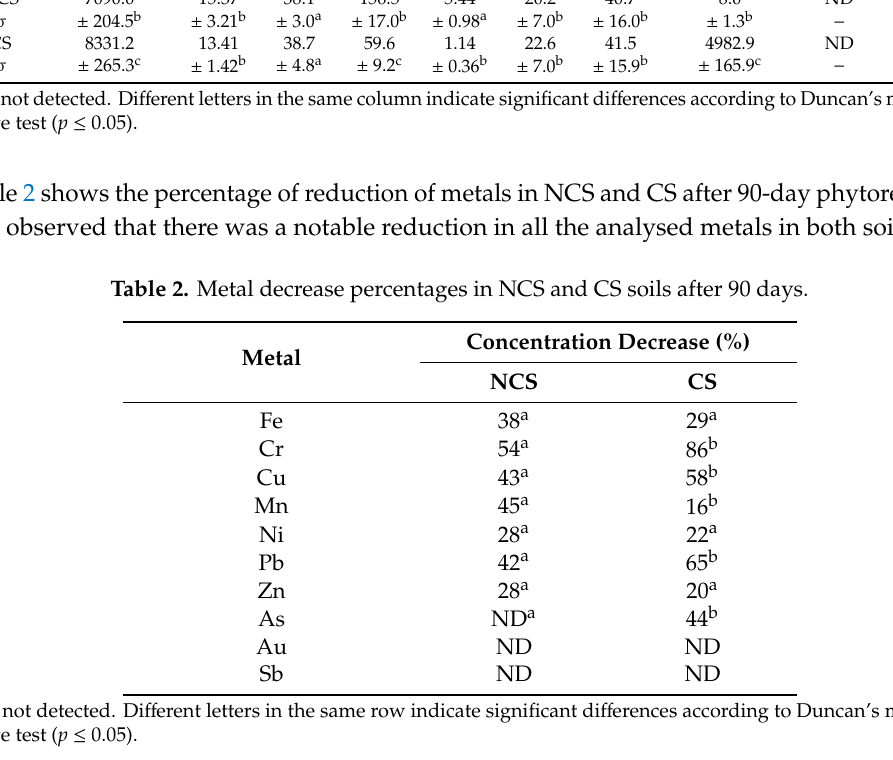
ND: not detected. Different letters in the same row indicate significant differences according to Duncan’s multiple range test ( p ≤ 0.05).